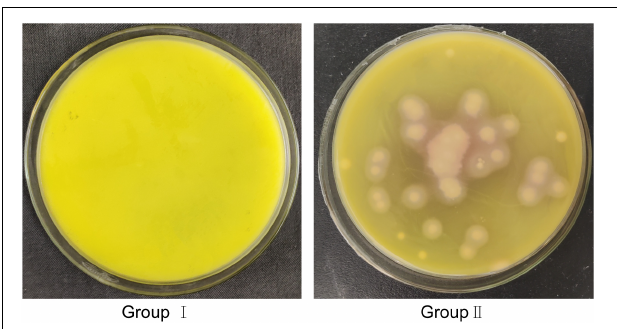
FIGURE 8 | Cultivation of EG-Q3 in E. grisescens in MYP medium.